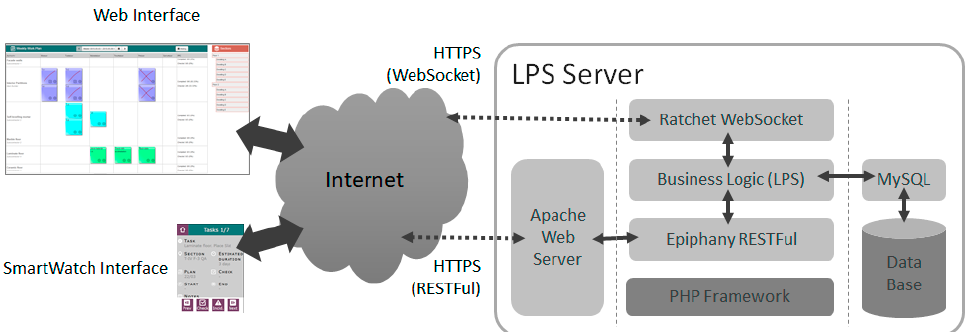
Figure 12. Prototype LPS.